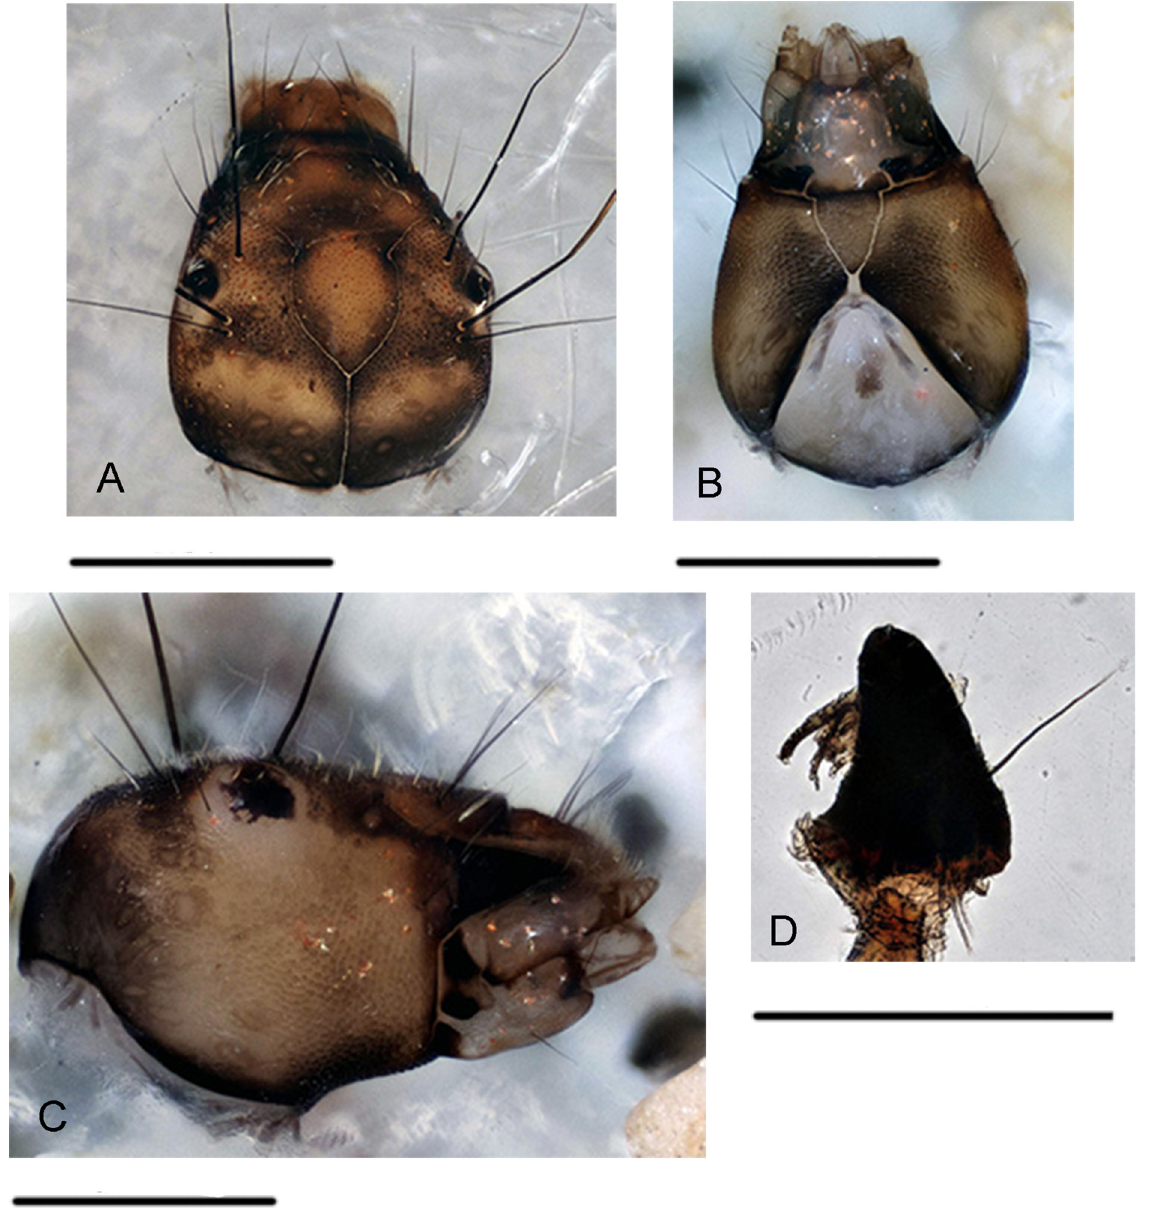
Fig. 9 . Head of Apatidelia acuminata Leng & Yang, 1998, larva. A . Dorsal view. B . Ventral view. C . Lateral view. D . Right mandible (lateral view). Scale bars: A–C = 0.5 mm; D = 0.25